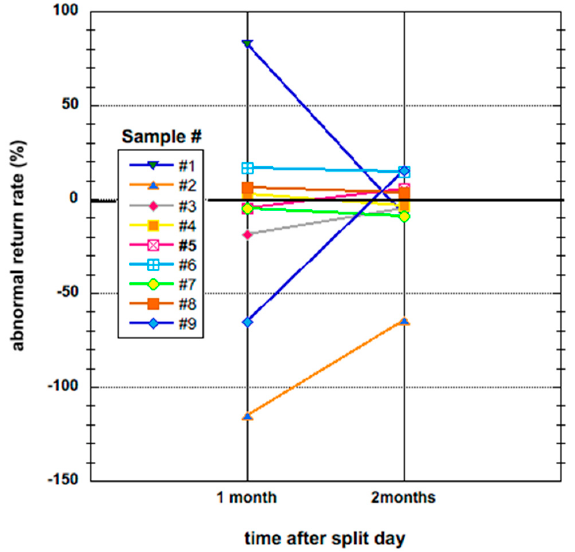
Figure 11 . Abnormal return rates. Figure 11. Abnormal return rates, calculated with for base the − 120 day share price.